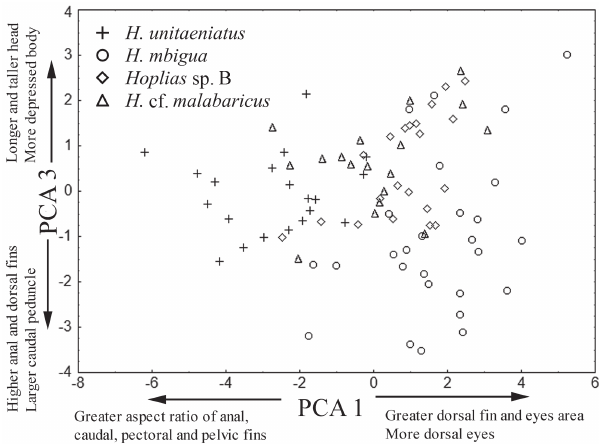
Fig. 1. Distribution of scores of non-native ( H. mbigua and H. unitaeniatus ) and native ( Hoplias sp. B and